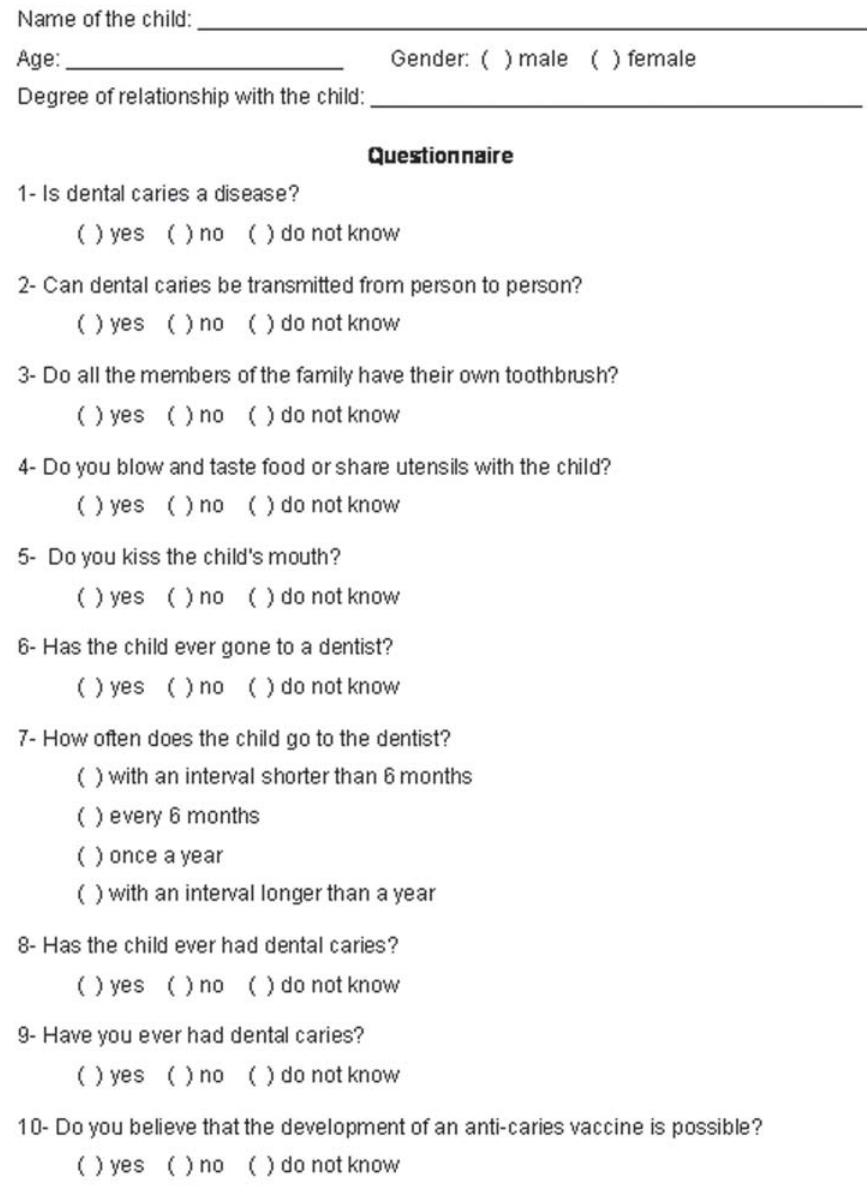
FIGURE 1- Questionnaire applied to assess the knowledge and attitude of the parents or caretakers of 0 to 5-year-old children regarding the transmissibility of dental